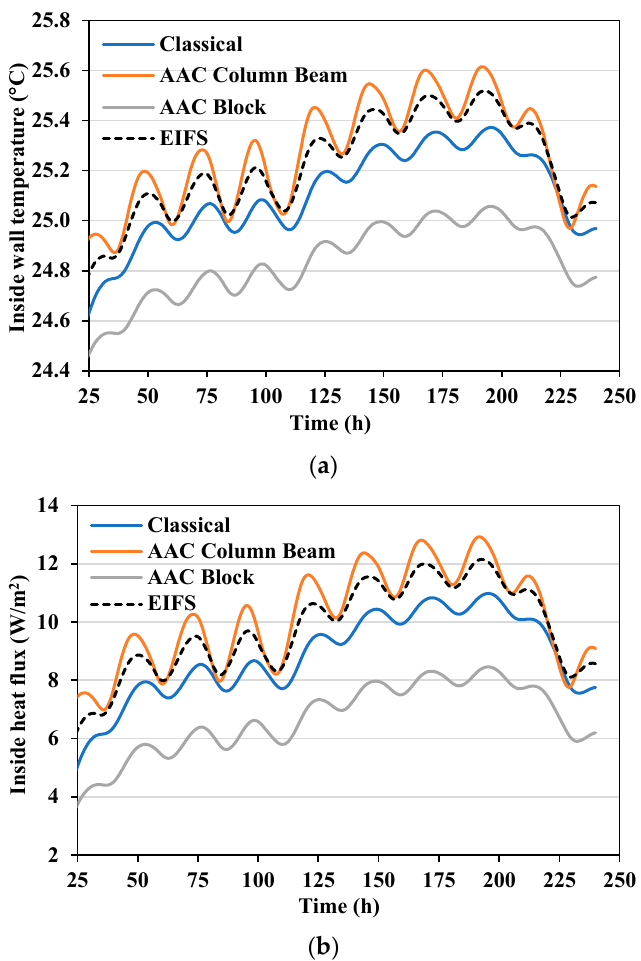
Figure 7. Inside wall temperature and heat flux of the thermal bridges of the ground floor using tested four walls. ( a ) inside wall temperature, ( b ) inside heat flux.